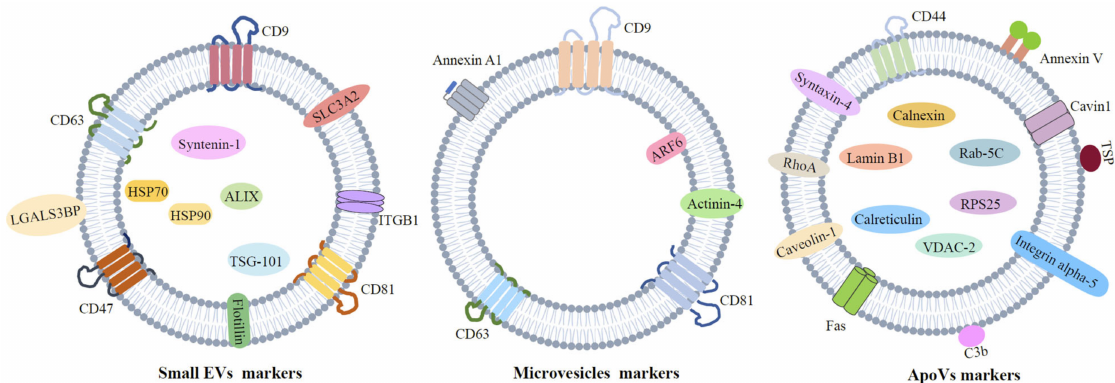
Figure 2. The markers of different kinds of EVs. The possible markers of sEVs, MVs, and ApoVs are briefly